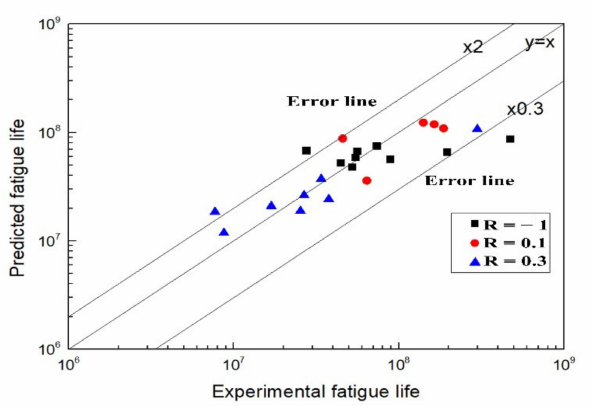
Figure 13. Comparison between predicted and experimental fatigue